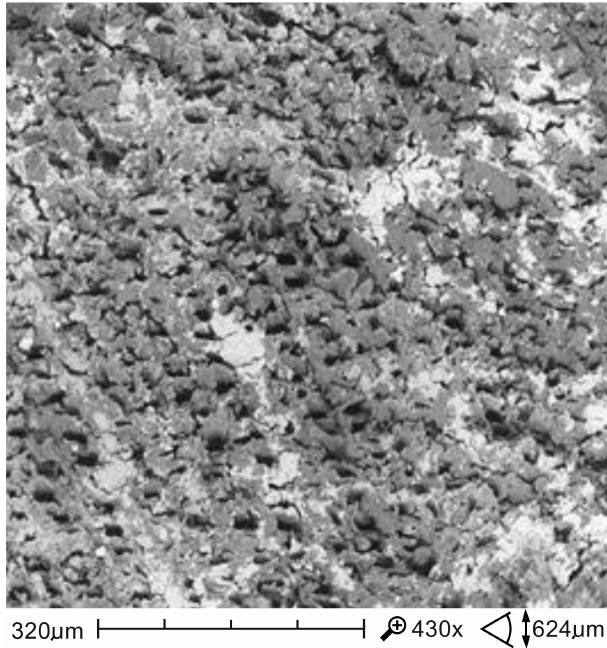
Figure 7. SEM images of the impregnated porous wood structure at a magnification of 430 ×